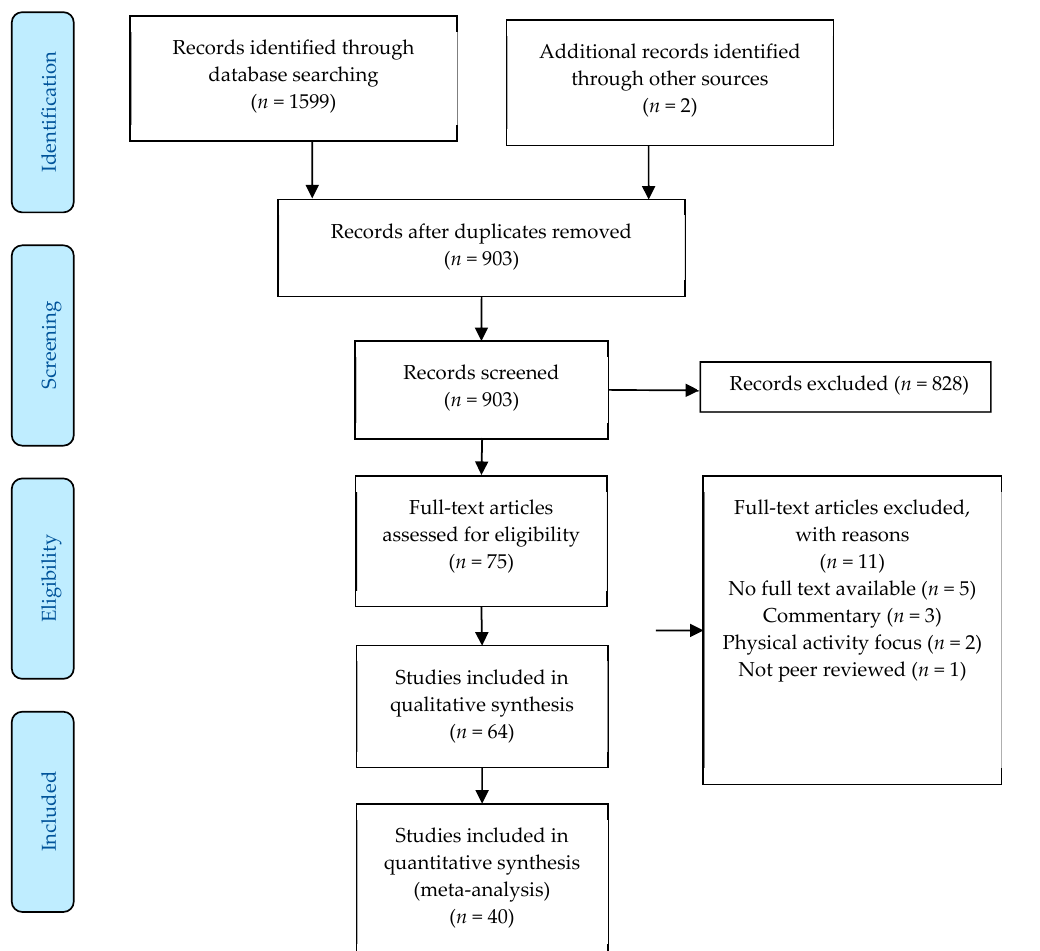
Figure 1. Schematic flow diagram of the systematic review and meta-analysis process.